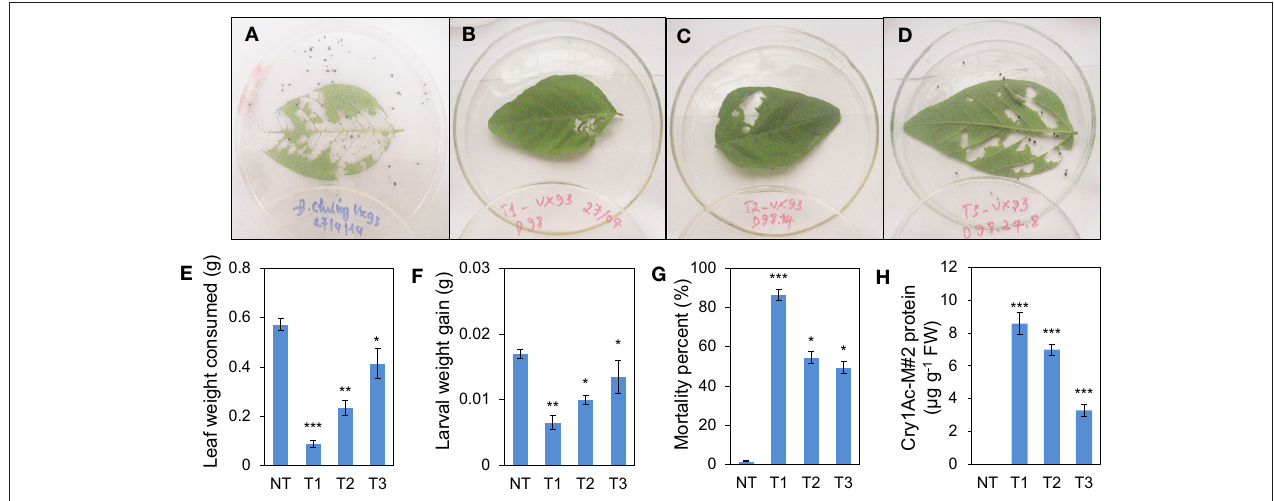
FIGURE 5 | Insect feeding bioassay of transgenic lines No. 98. (A) Detached leaf assay in VX93 non-transgenic (A) and transgenic line (VX93-M#2) from T1 to T3 generations (B–D) , respectively. (E) average leaf consumed by neonates in all transgenic lines T0 to T3 compared with non-transgenic VX93 (control). (F) Lower average larval weight gain. (G) Significant higher percent mortality of neonates in transgenic VX93 line (T1 to T3 generations) compared to VX93 non-transgenic (NT). (H) Cry1Ac-M#2 protein content detected by Elisa analyzing. Values are represented as mean ± SE ( n = 3). Asterisks indicate significant differences between the control and pathogen-stressed plants; * P < 0.0 5, ** P < 0.0 1, *** P < 0.0 01.